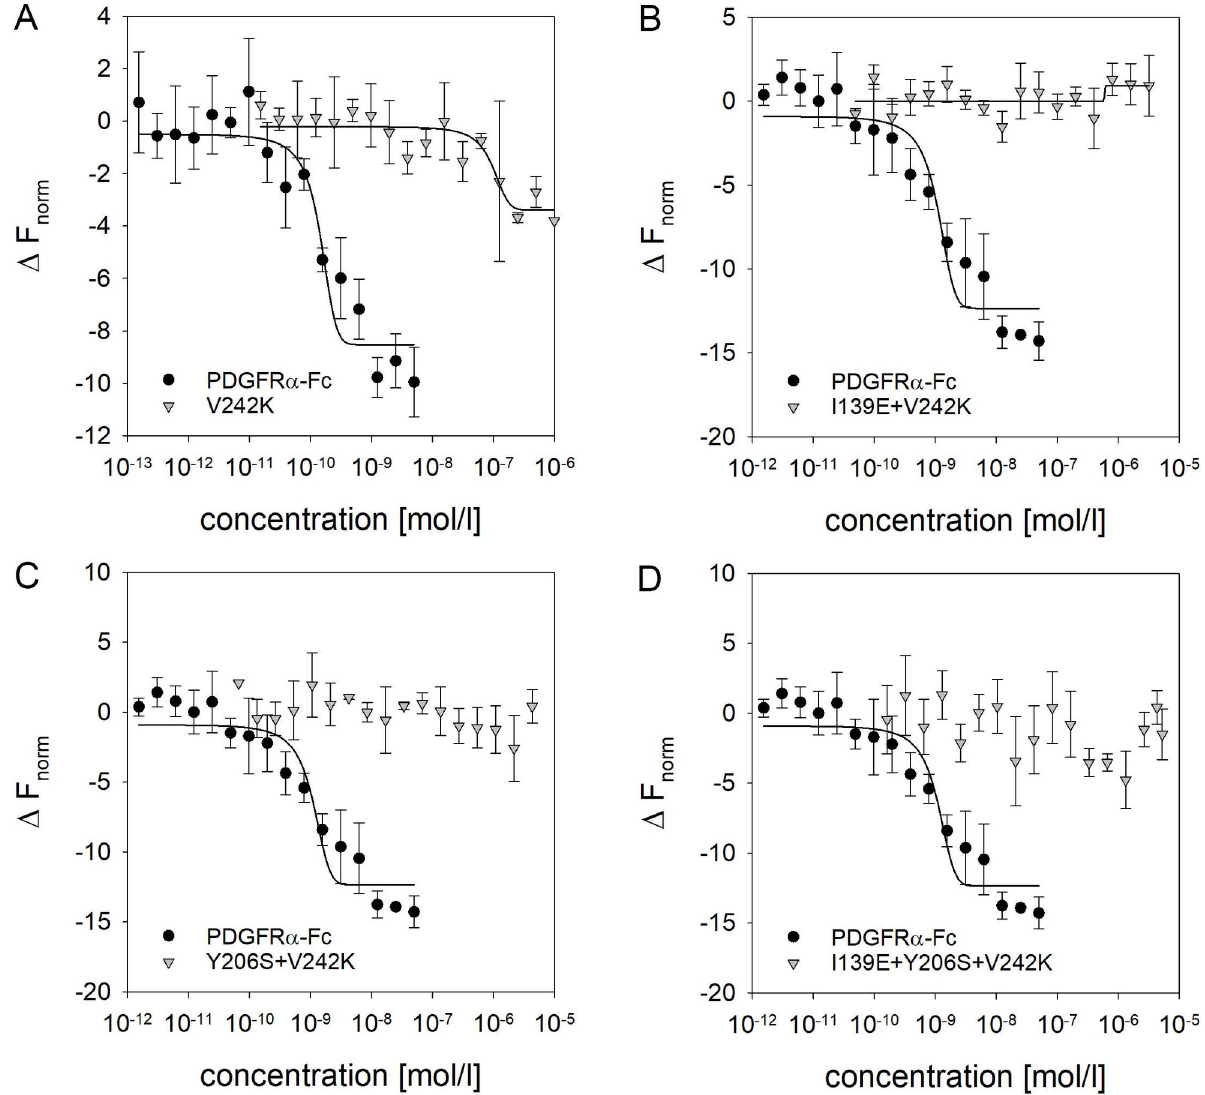
Fig 10. Combination of multiple mutations affecting PDGF binding reduces the affinity of PDGFR α -Fc for PDGF beyond detection. Quantification of biochemical binding affinity of PDGFR α -Fc variants for PDGF-BB was assessed by microscale thermophoresis. Various concentrations of PDGFR α -Fc wildtype, PDGFR α -Fc V242K (A), PDGFR α -Fc I139E + V242K (B), PDGFR α -Fc Y206S + V242K (C) or PDGFR α -Fc I139E + Y206S + V242K (D) were mixed with 0.1 nmol/l ( A ) or 1 nmol/l ( B to D ) fluorescently labeled PDGF-BB. Binding curves were generated by analysis of the ratio ( Δ F norm ) of fluorescence at MST -on time (1.5–2.5) seconds over the steady-state fluorescence (F0) for each concentration. Measurements were performed at 60% excitation power ( A ) or 20% excitation power ( B ). Error bars indicate standard deviation from 3 replicate